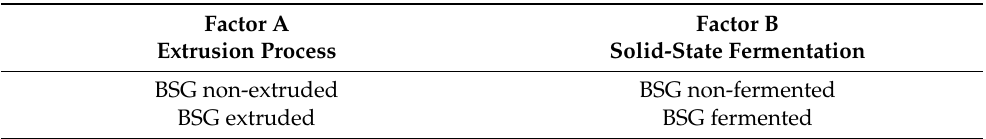
Table 1. Experimental design of the study.